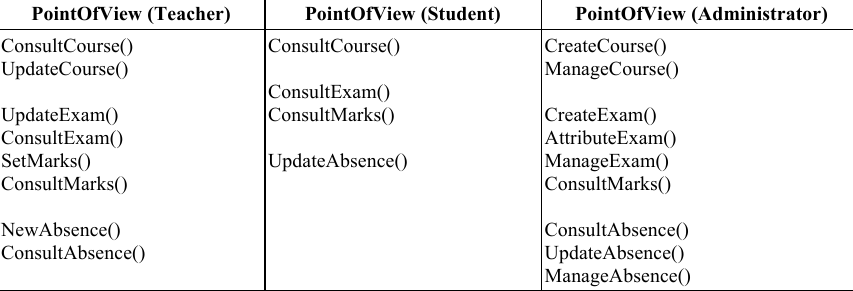
Table 2. Automatically generated Points of view of the School study